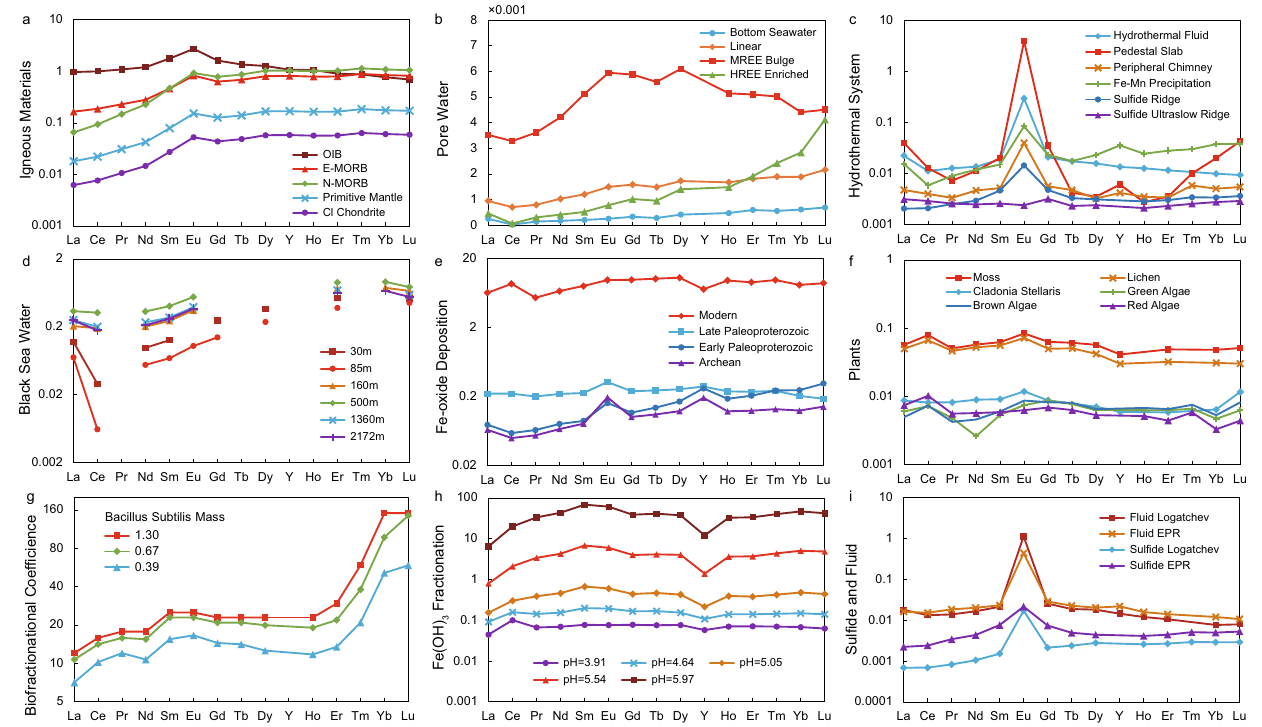
Fig. 6 Compilations of rare earth element pattern. All rare earth element (REE) data are normalized to post-Archean Australian shale (PAAS) 44 . a REE pattern of igneous rocks. All samples show Eu positive anomalies. All except for oceanic island basalt (OIB) show light REE (LREE)-depleted pattern; b REE pattern of porewater. REE pattern of the bottom water is similar to that of seawater. The middle REE (MREE) bulge type is found in Fe rich cores. The heavy REE (HREE)-enriched type is found in Fe lean cores. All samples slightly enrich in HREE 45 ; c REE pattern of hydrothermal fl uids and precipitates. Most samples show a fl at REE pattern, except for the pedestal slab near chimney showing a MREE-depleted pattern 17,19,50 . All samples show a positive Eu anomaly except for sul fi de from ultraslow spreading ridge. Pedestal slab and Fe – Mn precipitation show a slight Y enrichment 50 . d REE pattern for Black Seawater. Strong Ce negative anomaly could be characterized in shallow water. Deep water shows fl at REE pattern with slight HREE enrichment 46 . e REE pattern of Fe-oxide deposition. Modern samples are ferrihydrite precipitation on sea fl oor, while samples from Paleoproterozoic and Archean era are banded-iron-formation (BIF). Modern samples show fl at pattern with slight Ce positive anomaly and negative Y anomaly. BIF samples show positive Eu and Y anomaly 48 . f REE pattern for modern primordial plants including lichen, algae, and moss. 53,54 All samples show a fl at REE pattern, except for green algae that is slightly depleted Nd (ref. 54 ). g Fractional coef fi cient for microbes. Different lines show fractional coef fi cient for different biomass concentration. Microbes preferentially absorb HREE 57 . h REE fractionation during Fe(OH) 3 precipitation. All data show LREE-depleted pattern with a slight Y negative anomaly. Smaller fractionation is observed in acidic environment 47 . i Comparison of REE pattern for fl uid end-member and sul fi de from Logatchev (mid- ocean ridge in Atlantic Ocean) and east Paci fi c rise (EPR) 19 . The REE pattern for sul fi de and fl uid end-member is generally similar. A smaller positive Eu anomaly and slight HREE enrichment might be caused by contamination of seawater 19